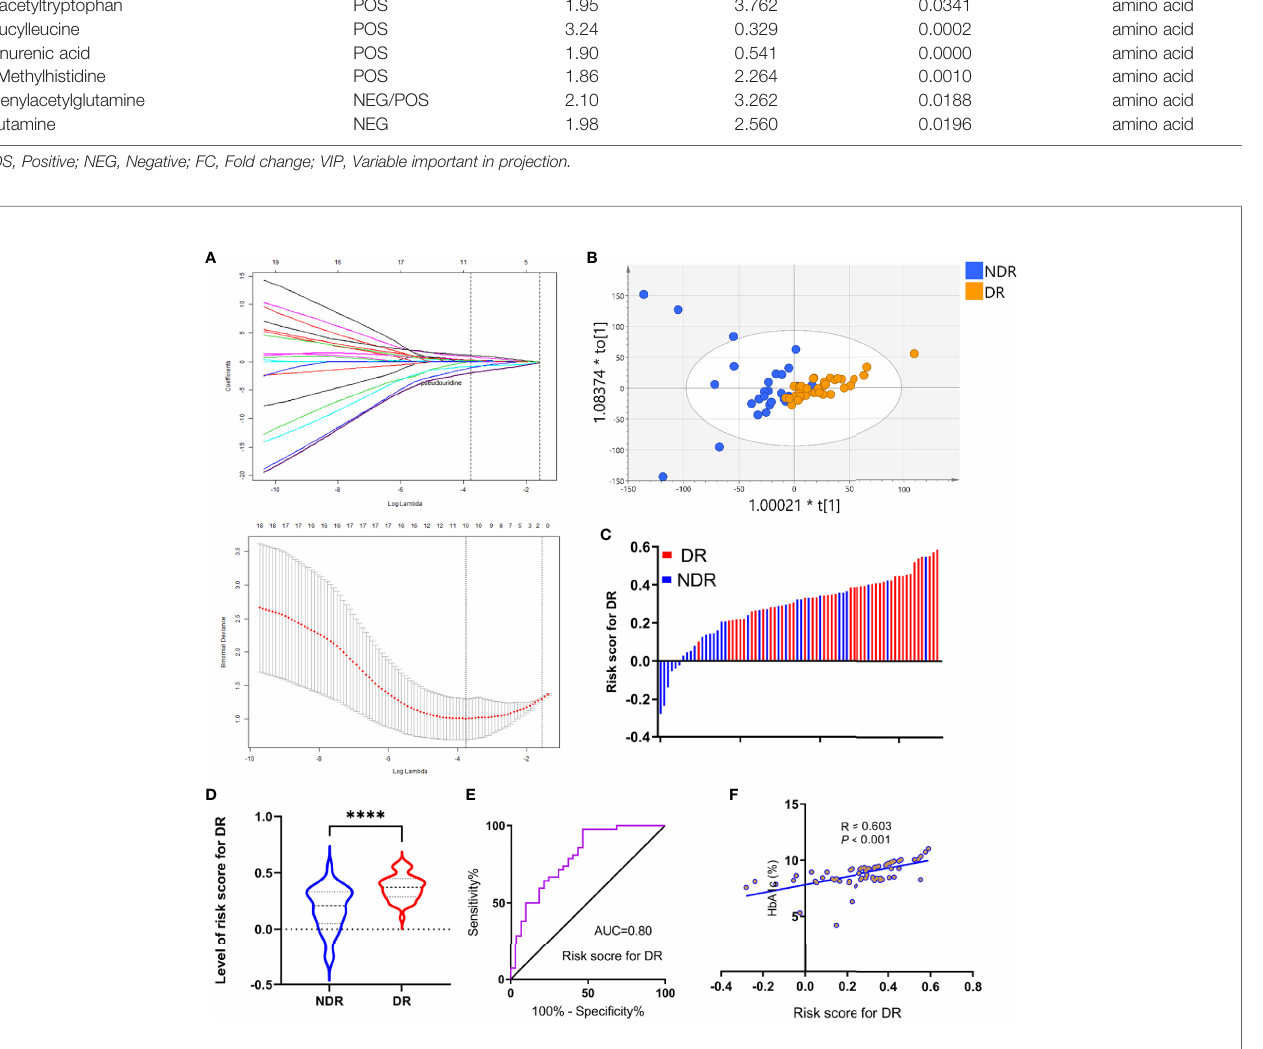
FIGURE 4 | Development of risk score for DR using the least absolute shrinkage and selection operator regularization (LASSO-LR) model. (A) Dotted vertical lines were drawn at the optimal values with Lambda (log), by using the minimum criteria and the 1 standard error of the minimum criteria (the 1-SE criteria). (B) OPLS-DA score plot of the analysis using selected metabolite. (C) Distribution of the risk score in the group. (D) Statistical analysis for distribution of risk score between DR and NDR (****p<0.0001). (E) ROC curves were created to evaluate the power of risk score. (F) A linear correlation analysis between risk score and HbA1c